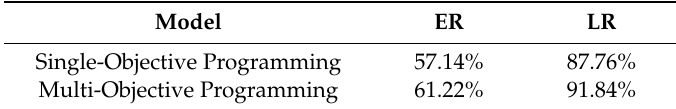
Table 7. Comparison of delivery time e ffi ciency between single-objective programming and multi- objective